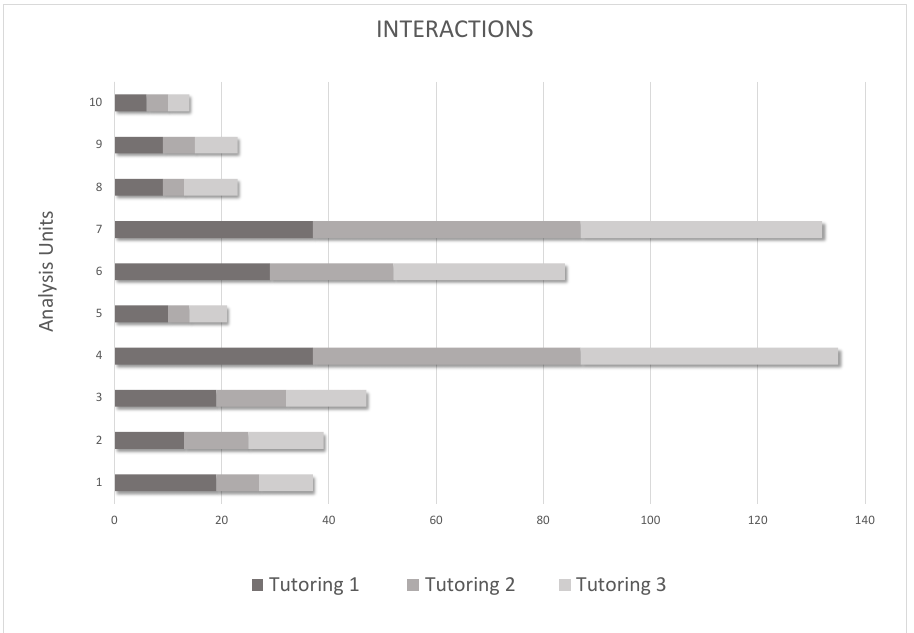
Figure 1. Graphical representation of the interactions per unit (colors represent types of tutoring (1, 2 and